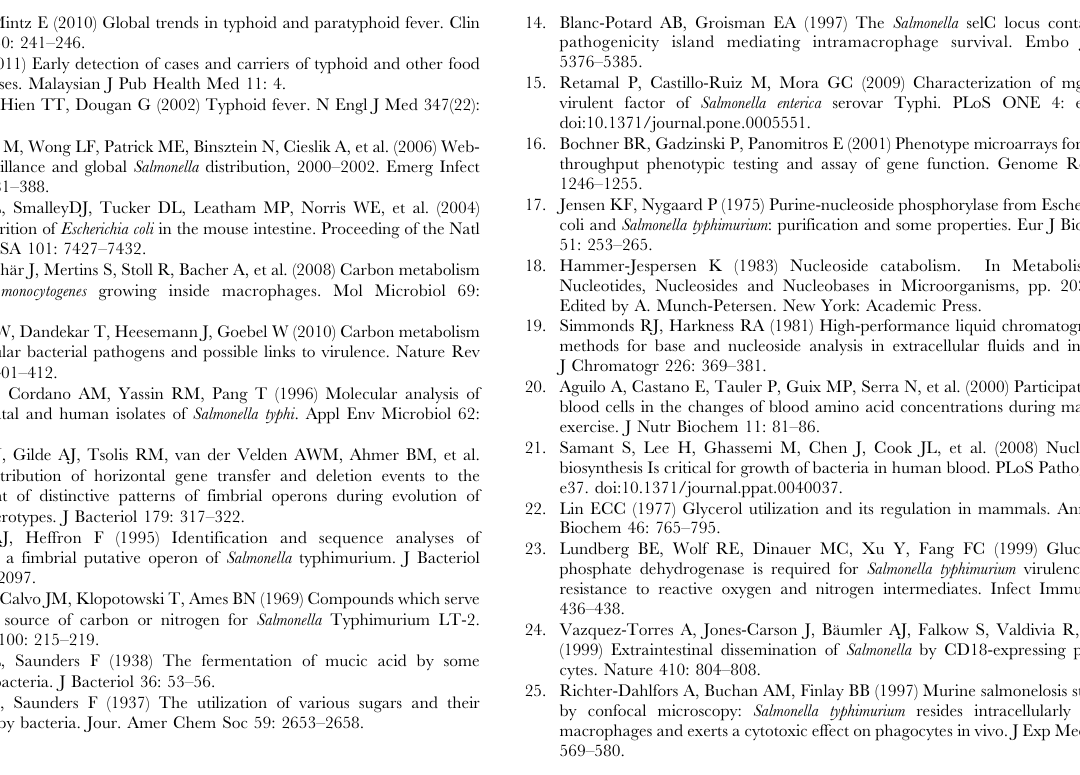
Table S1 Standardized value of the average area under the kinetic growth curve (catabolic rate) for each of the fifty-two carbon substrates catabolised by the S . Typhi strains. Table S2 One-hundred and ninety various carbon sources included in the carbon metabolic profiling of the eight S .